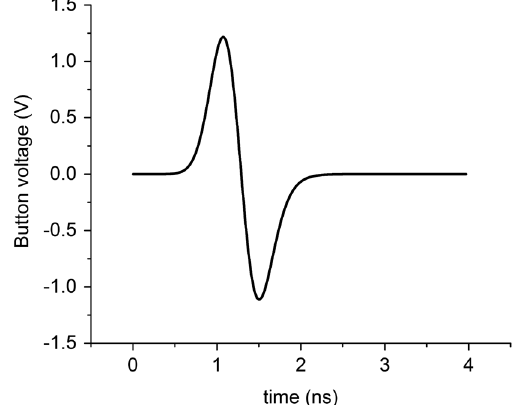
FIG. 14. Voltage signal induced at the button electrode of the IDBPI obtained through simulation with particle beam of rms length 60 mm.